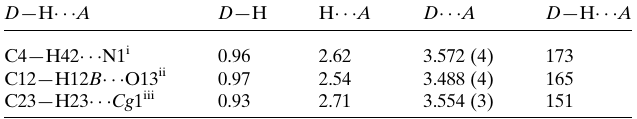
Table 1 Hydrogen-bond geometry (A˚ , (cid:3) ). Cg 1 is the centroid of the C21–C26 ring.